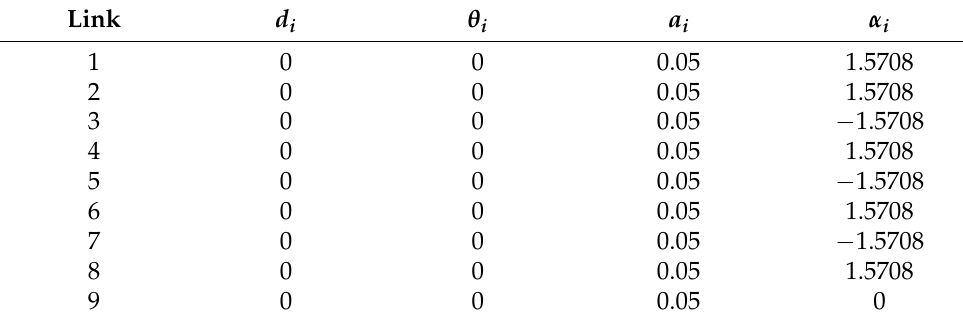
Figure 2. The simulated 9-degrees-of-freedom continuum robot. Table 1. Denavit–Hartenberg parameters of redundant